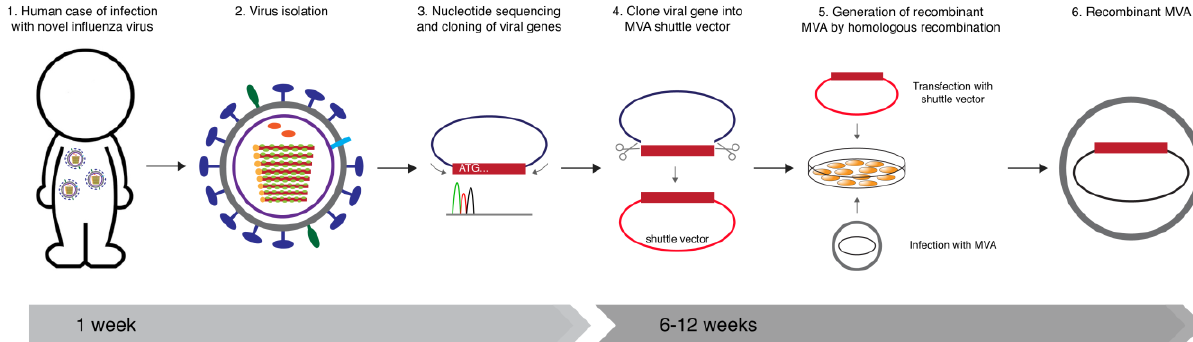
Figure 1. Ideal timeline for construction of an MVA-based vaccine after a human case of infection with a novel respiratory virus. Influenza virus is used as an example. ( 1 ) After the emergence of a novel respiratory virus with the ability of infecting humans, ( 2 ) the virus is isolated ( 3 ) and the sequence of a target gene of interest is obtained within a